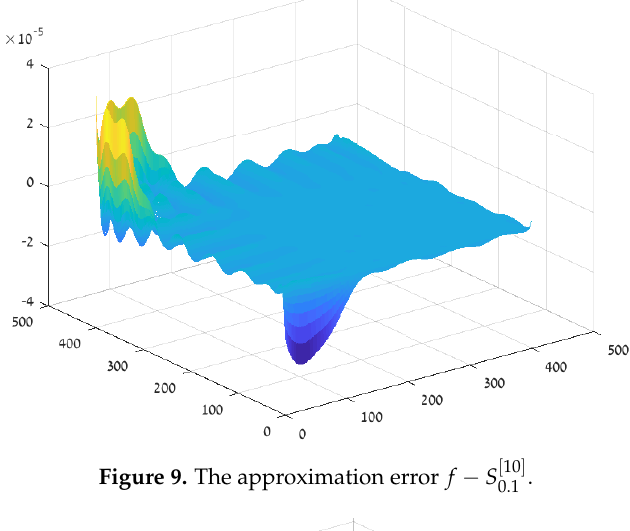
Figure 9. The approximation error f − S